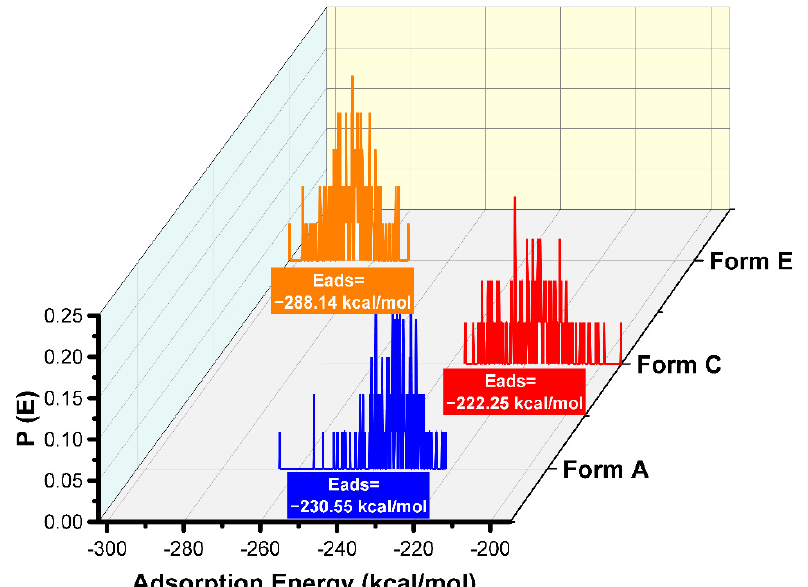
Figure 7. Distribution of the adsorption energies for the different protonated forms of the Pantopra- zole inhibitor on to the iron surface obtained via MC.